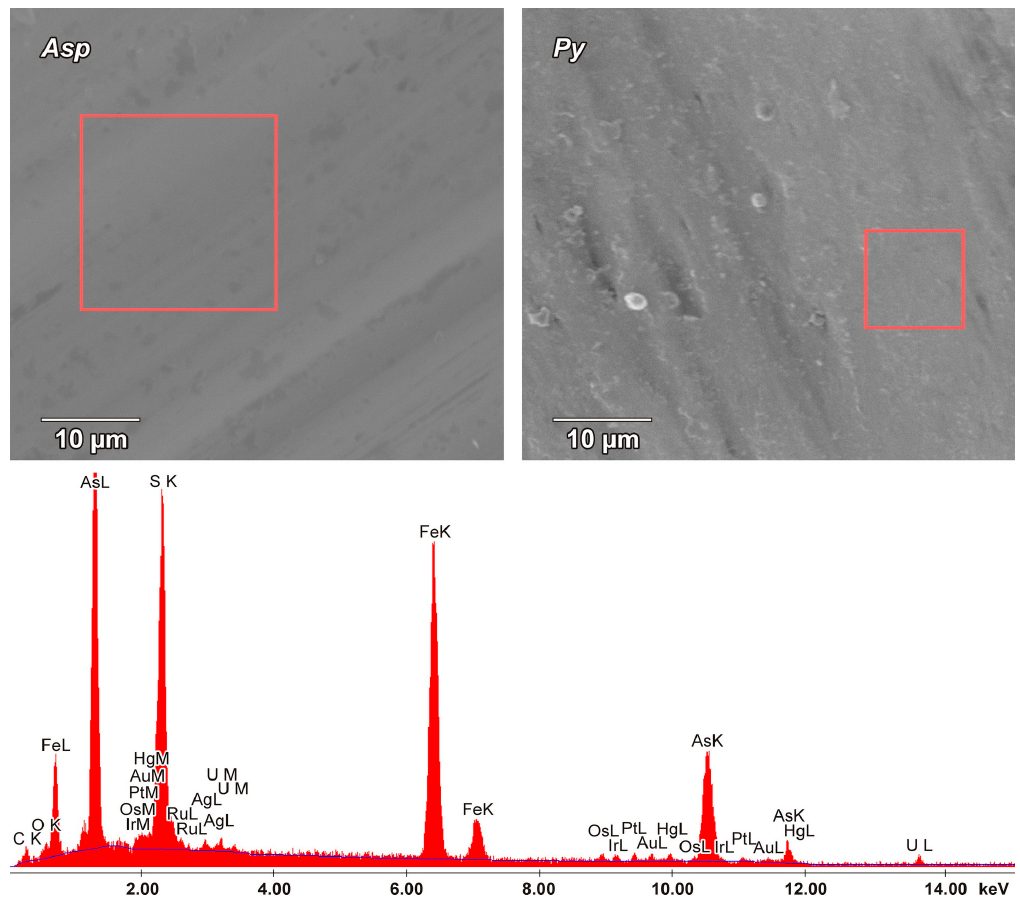
Figure 10. Enlarged fragments of arsenopyrite (Asp) and pyrite (Py) crystals with “clean” areas, where measurements were carried out (see Table 8, sample М -129/10, N 3, n 3 and Table 9, sample М - 129/10, N 1, n 2). The bottom of the Figure 9 shows the X-ray energy spectra of arsenopyrite (see Table 8, N 3, n 3).